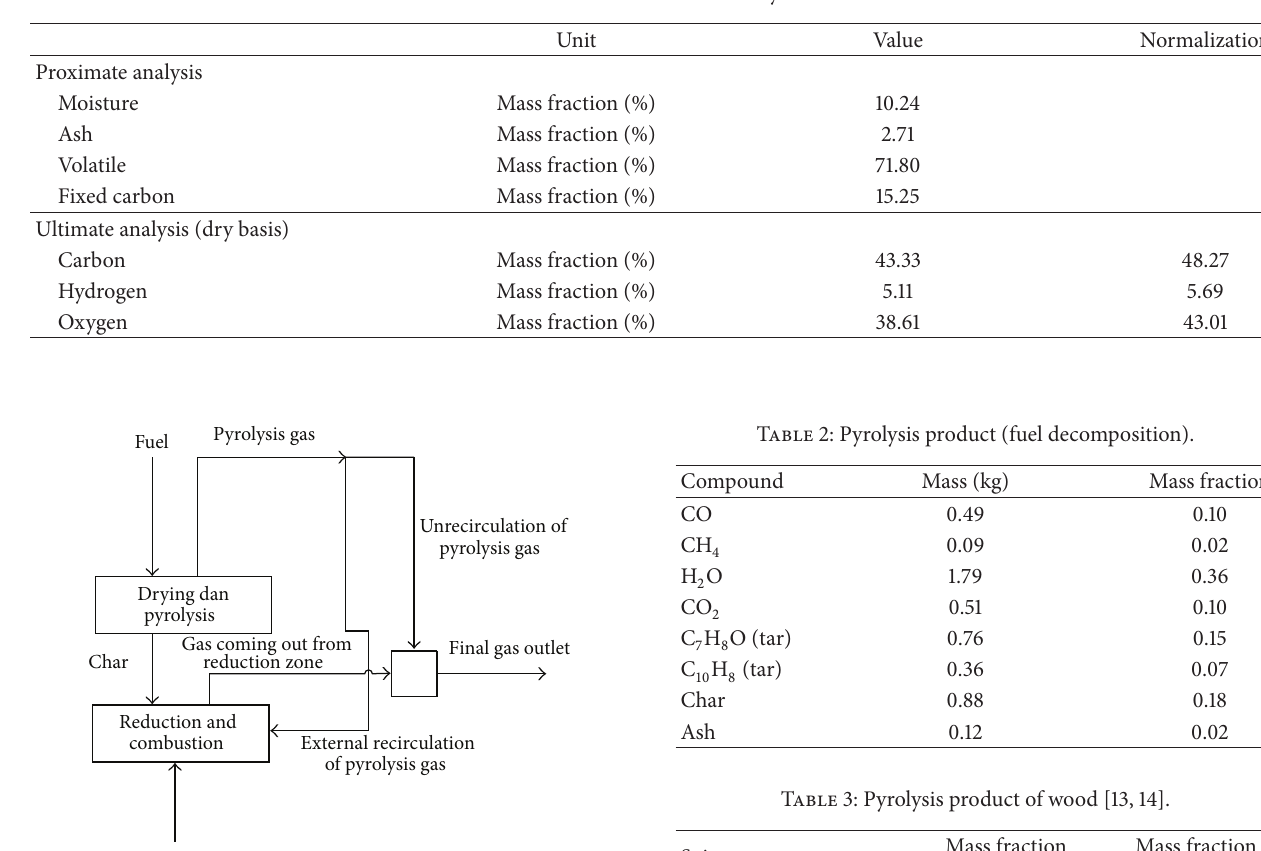
Table 1: Proximate and ultimate analysis of fuel.